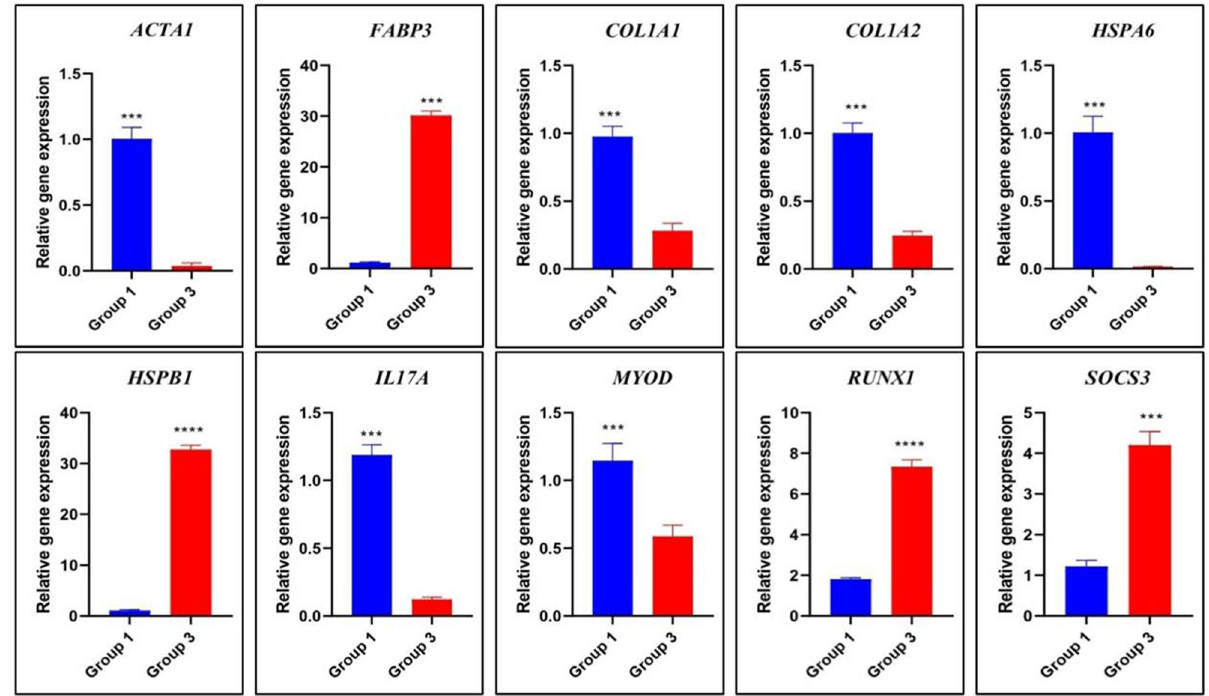
Figure 6. Relative expression of differentially expressed genes between Group 1 and Group 3 by quantitative PCR. Group1 = 2 tooth stage or 1 years; Group 3 = 6 tooth stage or 2.5–3 years.